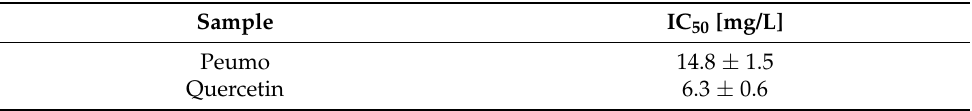
Data represent the average of three repetitions, with a corresponding standard error of the mean.